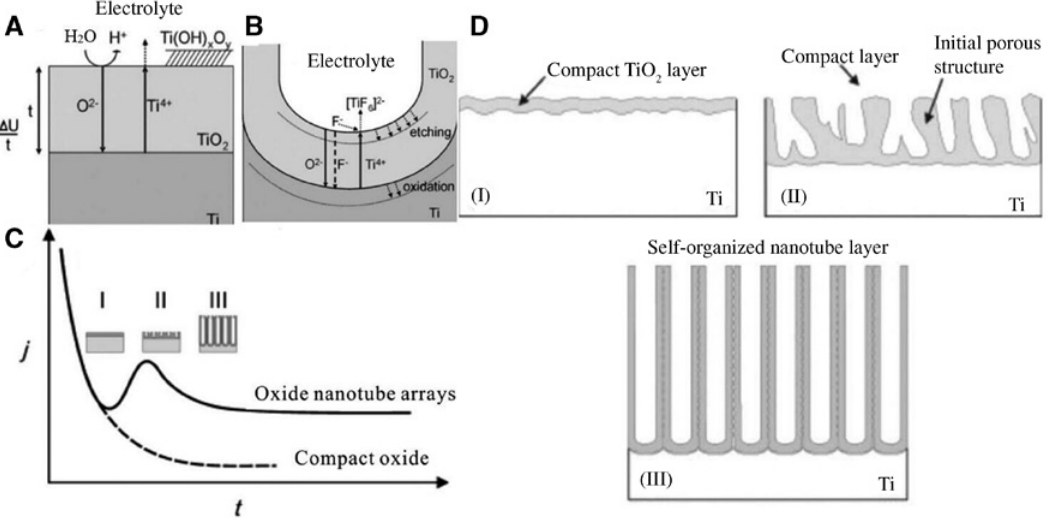
Figure 5: Schematic representation of the Ti anodization characteristics of the Ti anodization (A) and (B). Typical current-time (j-t) with and without fluorides in the electrolyte (C). Corresponding evolution of the TiO from Ref. [80] with permission. Copyright Royal Society of Chemistry